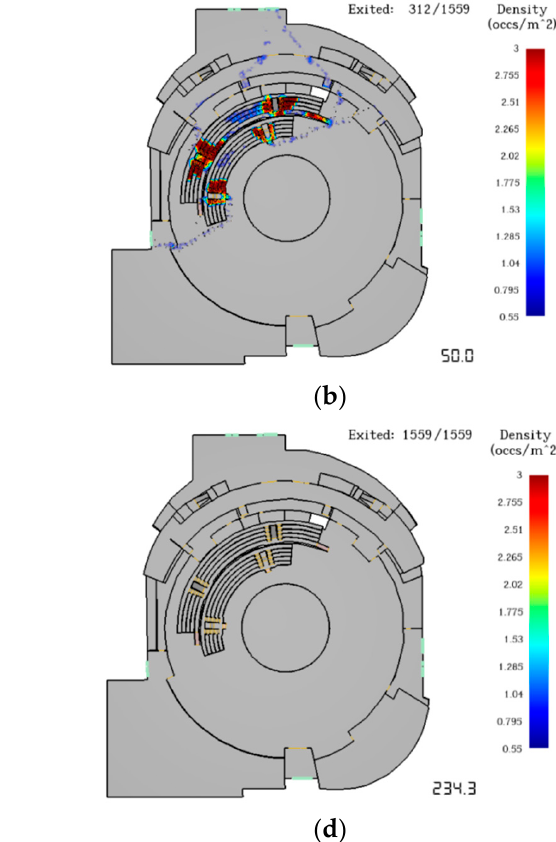
Figure 20. Location of the alternate evacuation stairs for auditorium B and auditorium C.